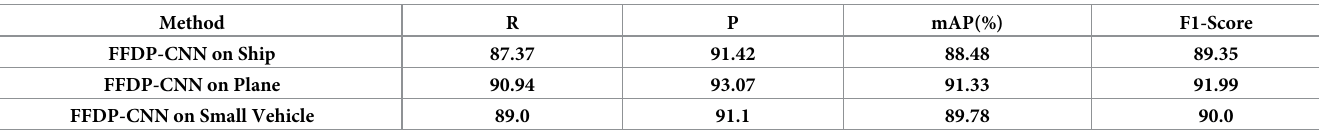
Table 13. F1-Measure on